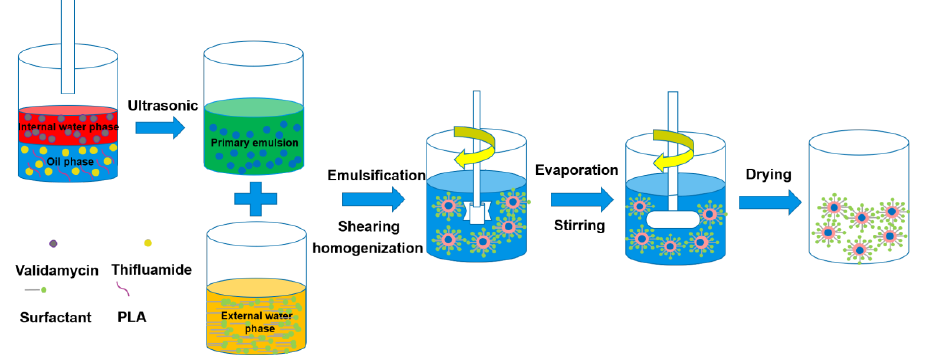
Figure 1. Schematic illustration of the preparation of dual-functionalized pesticide nanocapsules.